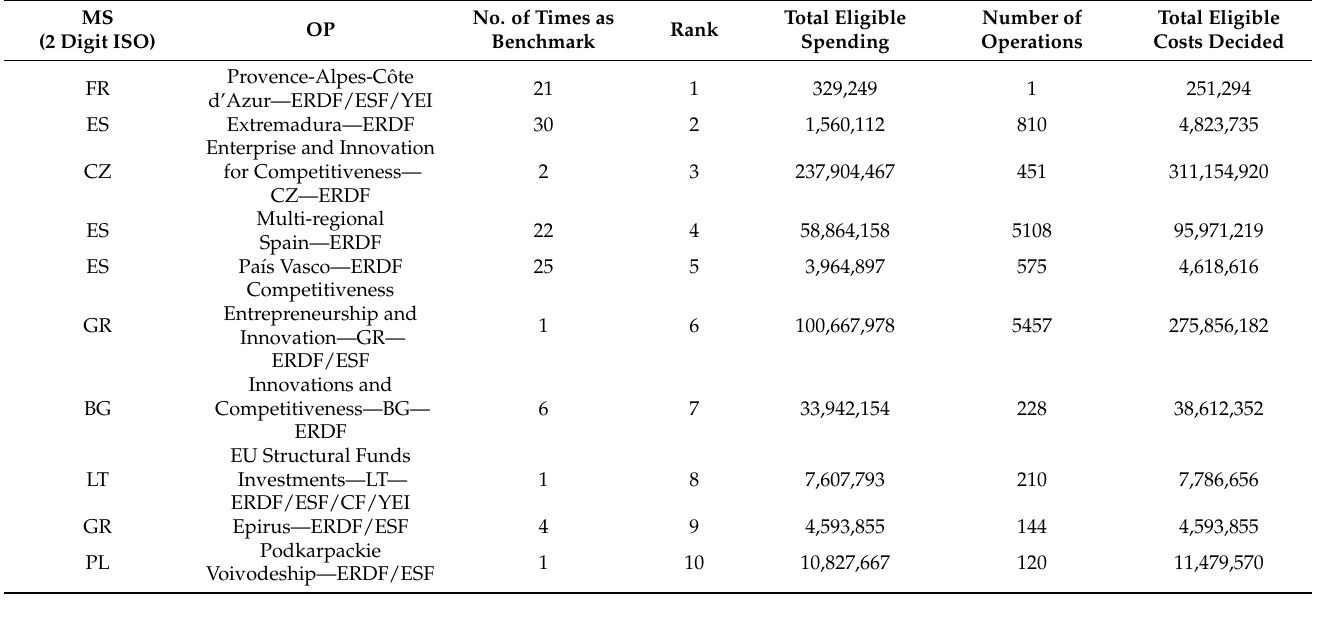
Table 7. Main characteristics of efficient OPs.